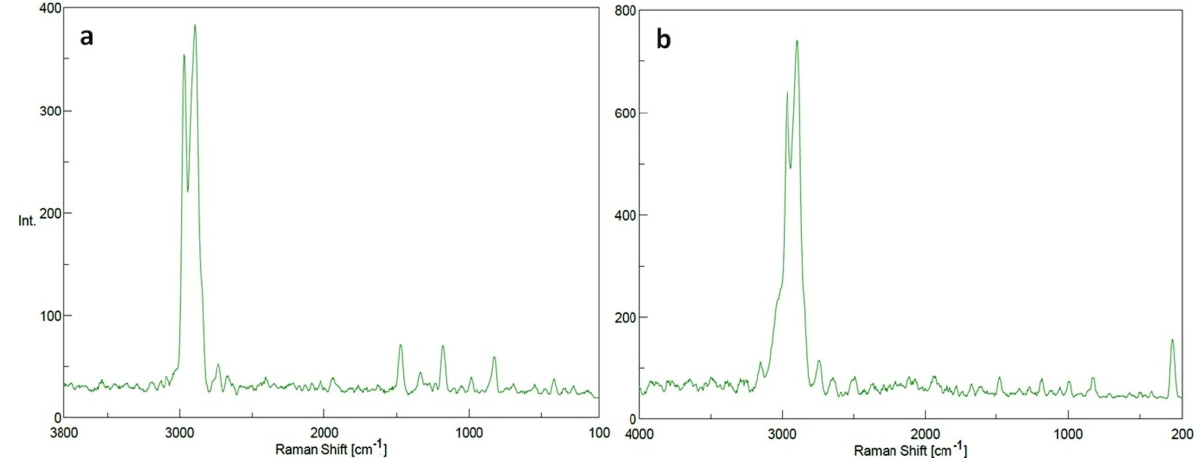
Figure 5. Raman spectrums of ( a ) PP fabric and ( b ) SeNPs-PP fabric.